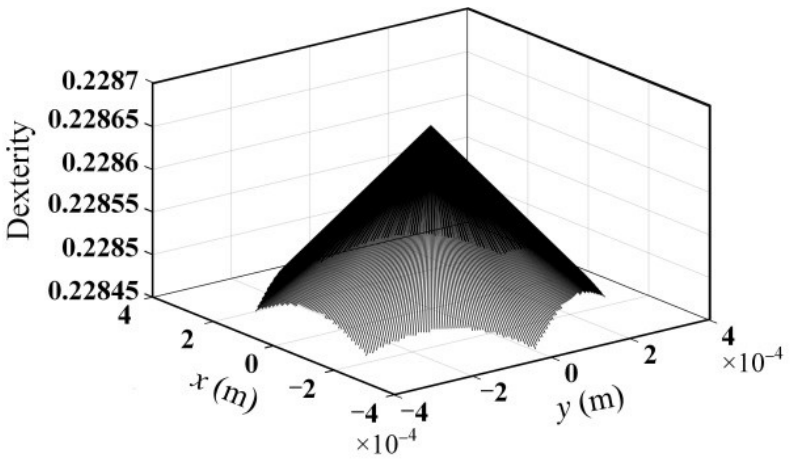
Figure 4. Dexterity within the maximum cross-section of the workspace of the mechanism.